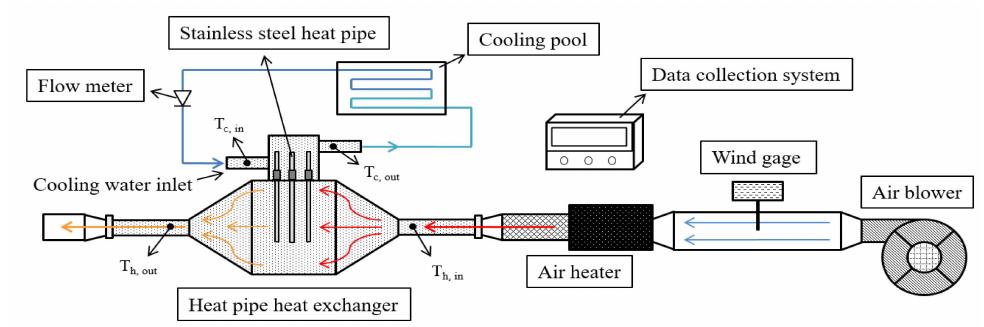
Figure 5. The experimental setup used for the testing of the heat pipe heat exchanger. The specifications of the equipment used for testing and mentioned in Figure 5 were as follows.